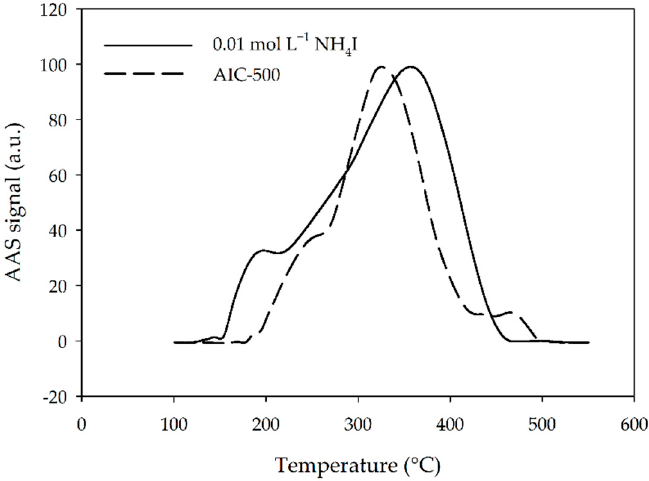
Figure 2. Fractionation thermograms for AIC-500 and in-house prepared iodinated activated carbon (0.01 mol L − 1 NH 4 I). Parts of the thermogram below 100 °C and above 550 °C were removed for clarity as the values for AAS signal were about zero. a.u.—arbitrary units.